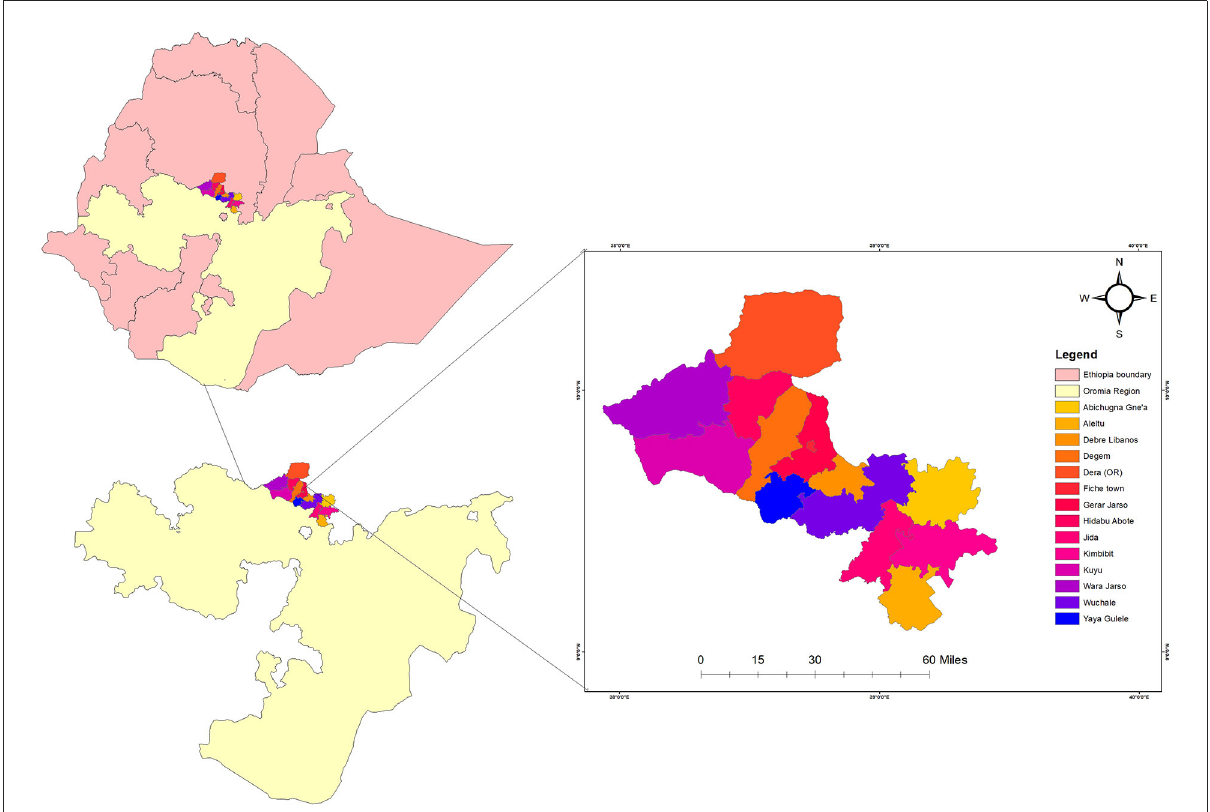
FIGURE1 Map of North Shewa Zone, Oromia regional state, Ethiopia,